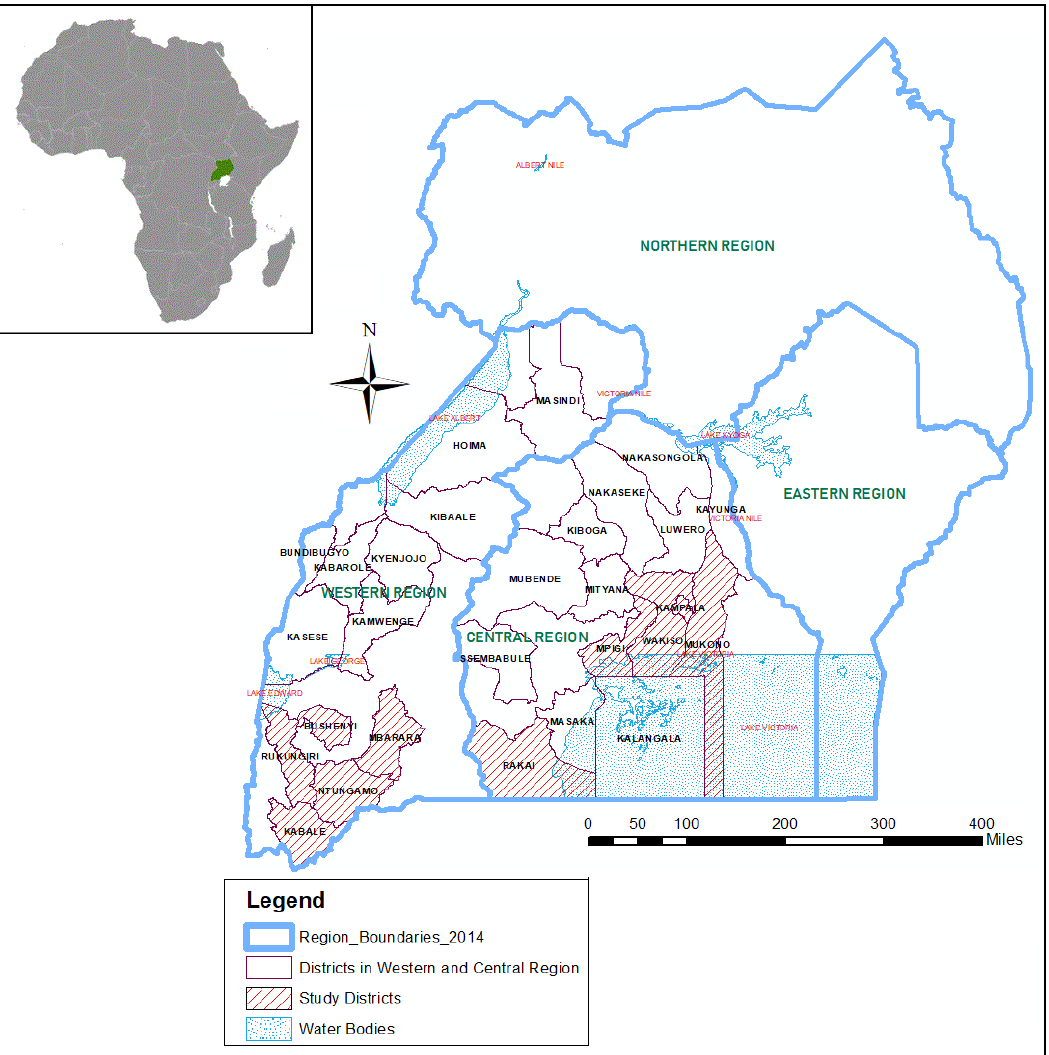
Fig. 1. Map of Uganda showing Central and Western